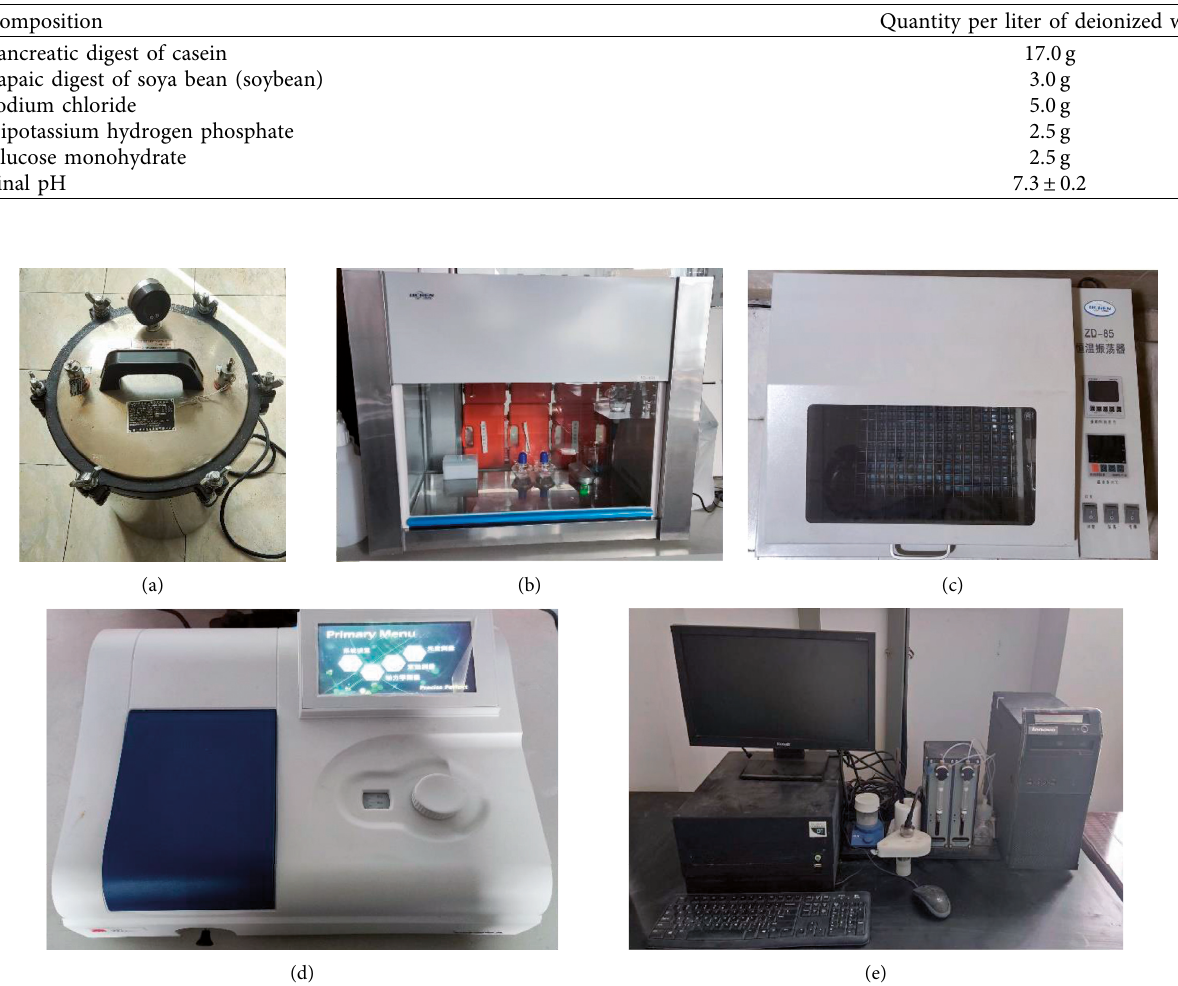
Table 4: TSB medium components (per liter).